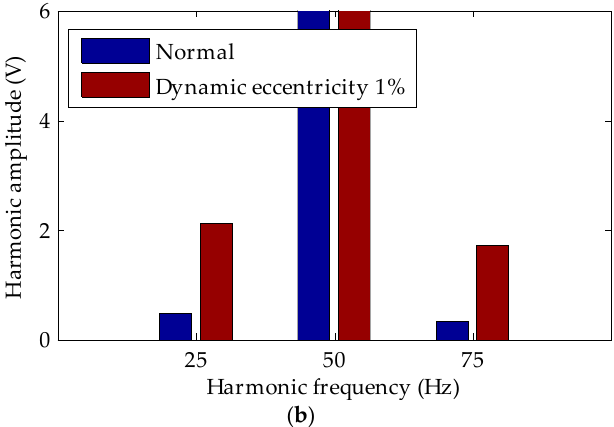
Figure 11. Induced voltage spectrogram for detection coils: ( a ) no-load; ( b ) rated load.